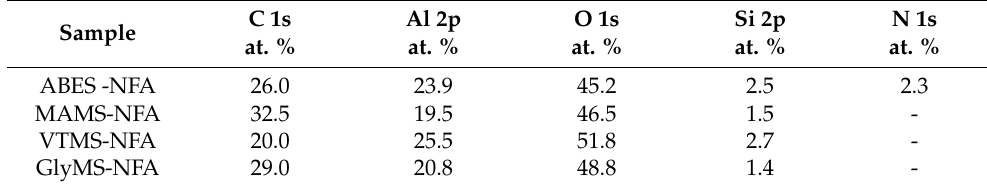
Table 1. XPS data of raw alumina nanofibers and treated with different silanes. C 1s Al 2p Sample at. % at. % at.